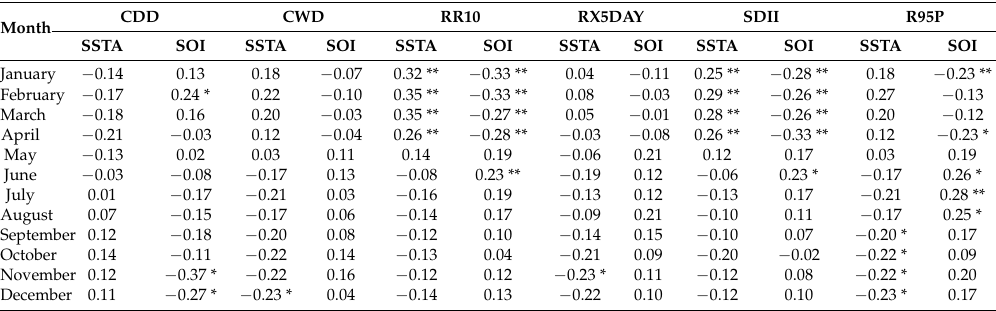
Table 6. Correlation between extreme precipitation indices and Sea Surface Temperature Anomalies (SSTA) and Southern Oscillation Index (SOI).